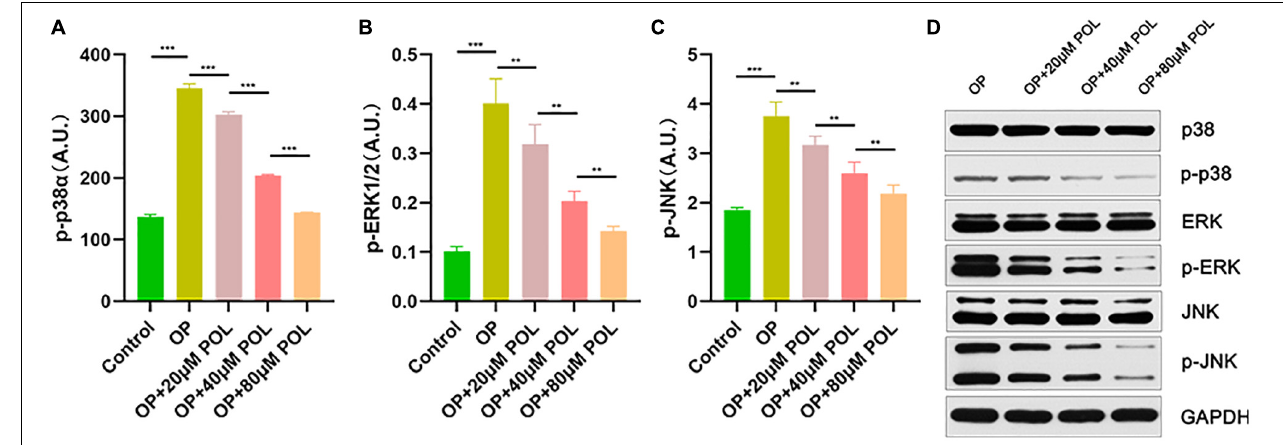
FIGURE 8 | Involvement of the MAPK signaling pathway in the regulation of POL. The relative expression of (A) p-P38, (B) p-ERK, and (C) p-JNK in the different groups [Control (PBS); OP; OP + 20 µ M POL; OP + 40 µ M POL; OP + 80 µ M POL] by ELISA is shown (** P < 0.05, *** P < 0.001). (D) The cellular OP models were treated with different concentrations of POL. Western blotting results of p38, p-p38, ERK, p-ERK, JNK, and p-JNK protein levels in